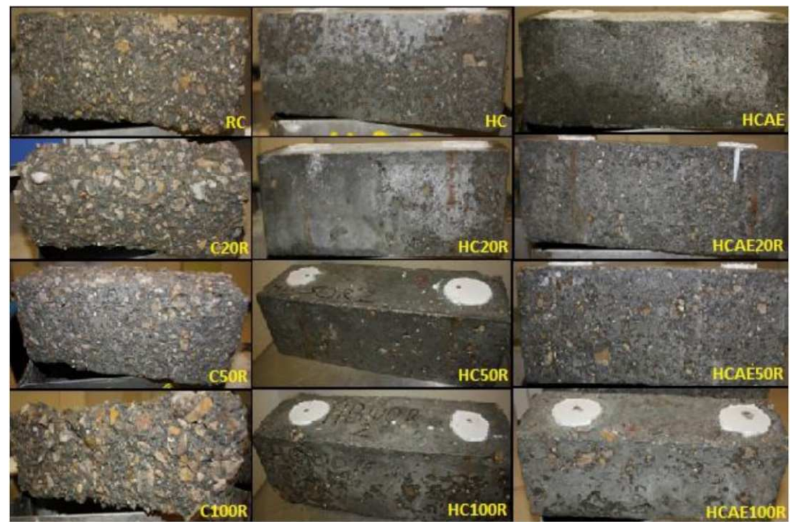
Figure 8. Macroscopic degradation of mixtures after 300 freeze–thaw cycles at different RFA replace- ment rates [109] (C: plain concrete with a water–cement ratio of 0.53; HC: high-strength concrete without SP and with an aerator (AEA), with a water–cement ratio of 0.35; HCAE: high-strength concrete with SP added but without an AEA, with a water–cement ratio of